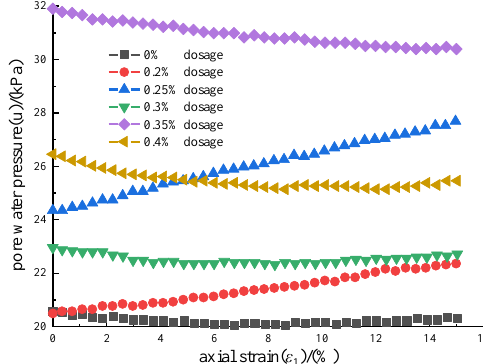
Figure 6. Relation curve between pore water pressure and axial strain at 300 kPa. (5) Under the same fiber content, the deviatoric stress of soil increases obviously with the increase in confining pressure. Taking fiber content of 0.3% as an example, the devia- toric stress of soil under confining pressure of 100 kPa, 200 kPa, 300 kPa, and 400 kPa is 115 kPa, 234 kPa, 345 kPa, and 457 kPa, respectively. The deviatoric stress of 400 kPa is 297.39% higher than that of 100 kPa, which indicates that increasing confining pressure can improve the failure strength of the soil.